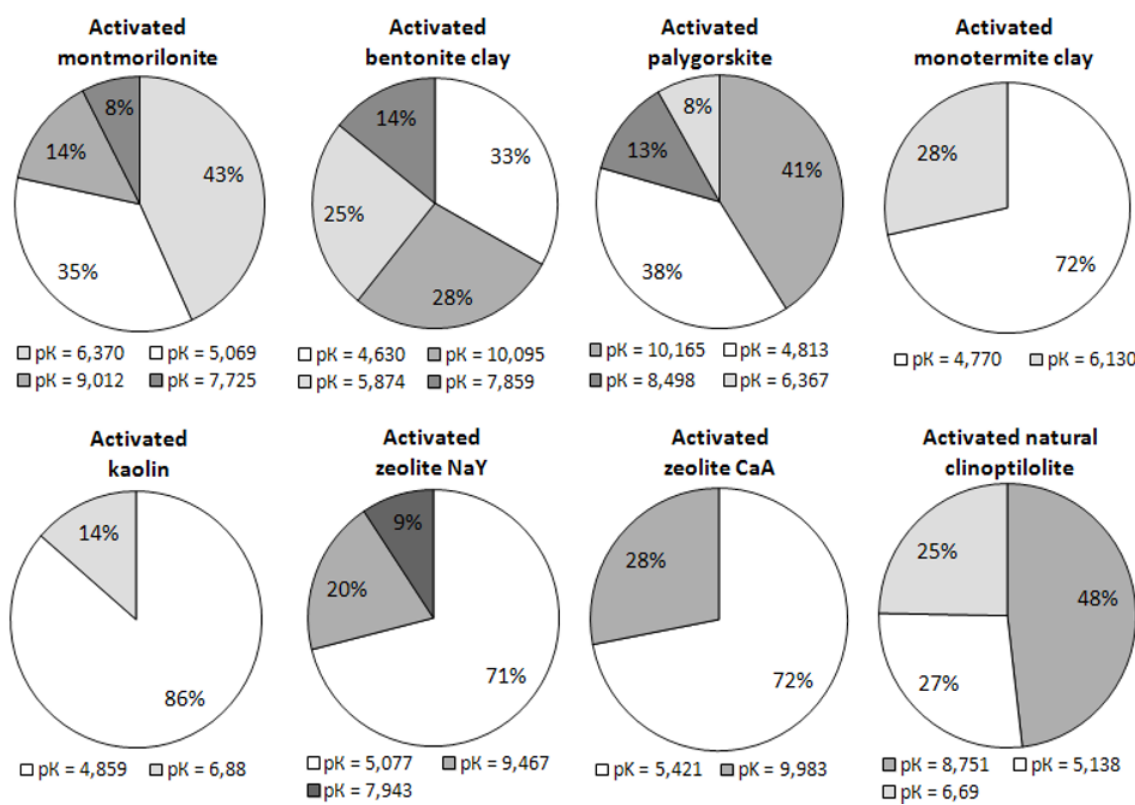
Figure 5. Distribution of active surface sites of different types in percents of the total amount of active